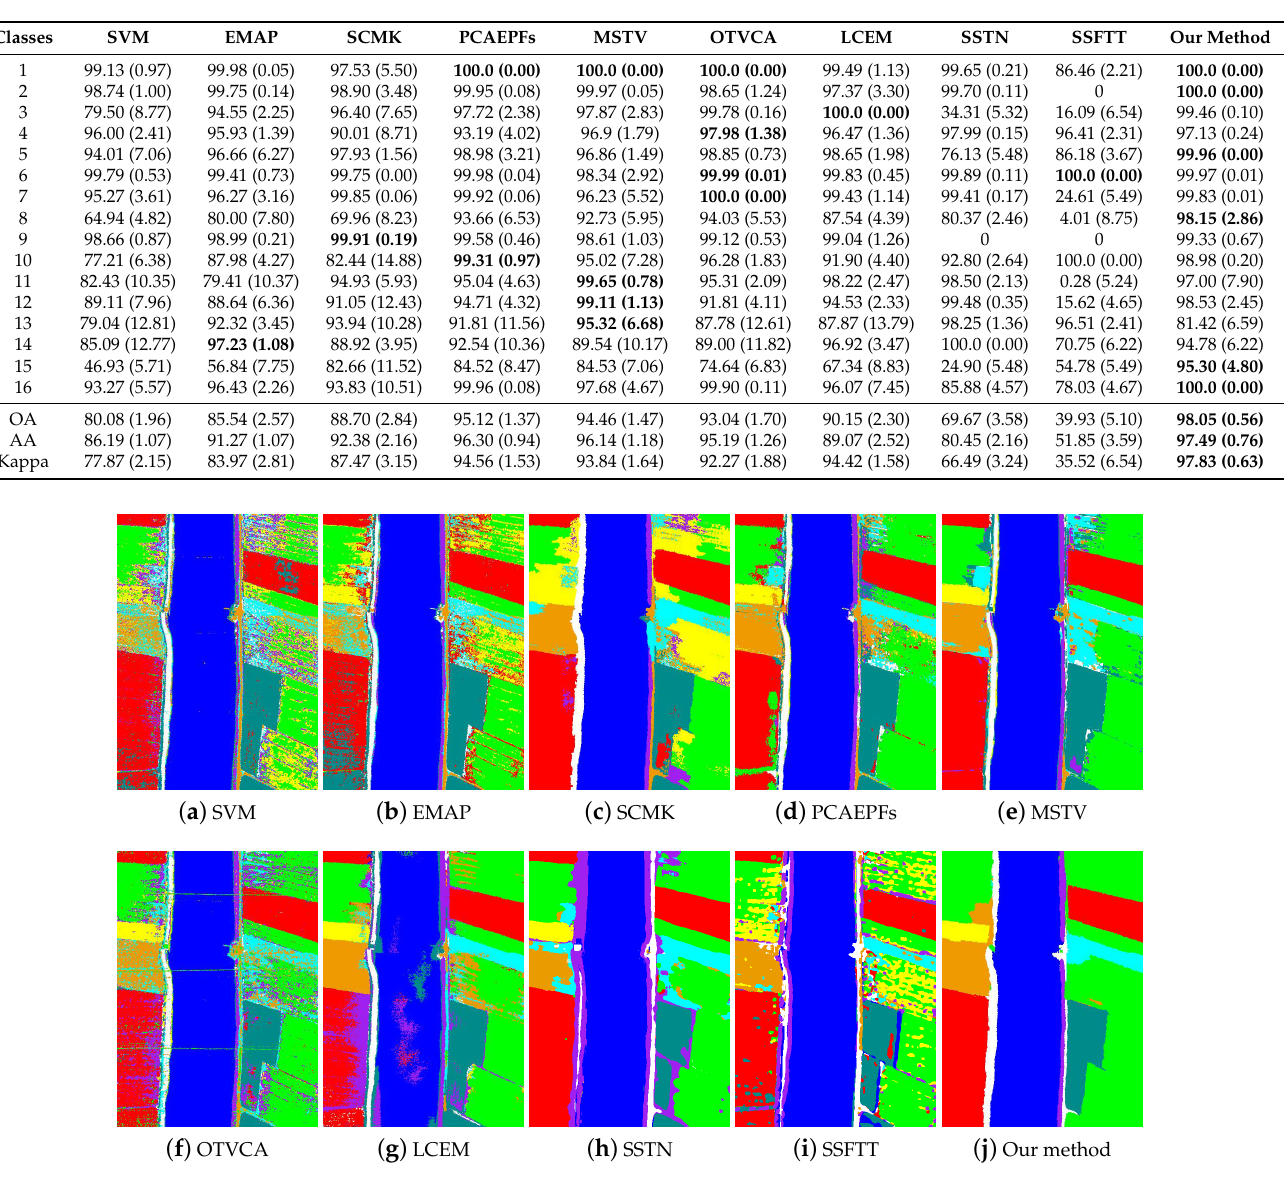
Figure 6. Classification maps of different classification methods on the Longkou dataset. ( a ) SVM [11], OA = 76.47%. ( b ) EMAP [38], OA = 81.20%. ( c ) SCMK [39], OA = 85.53%. ( d ) PCAEPFs [40], OA = 91.36%. ( e ) MSTV [6], OA = 91.51%. ( f ) OTVCA [41], OA = 82.51%. ( g ) LCEM [42], OA = 87.32%. ( h ) SSTN, OA= 90.38%, ( i ) SSFTT, OA= 81.22%, ( j ) Our method, OA =